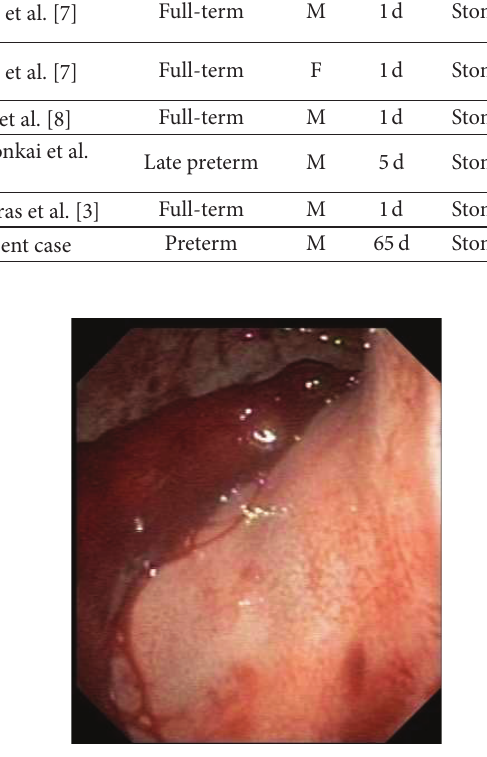
Figure 1: A big blood clot adherent to the gastroesophageal junction was seen in the 1st endoscopy. The clot could not be reached by endoscopy.